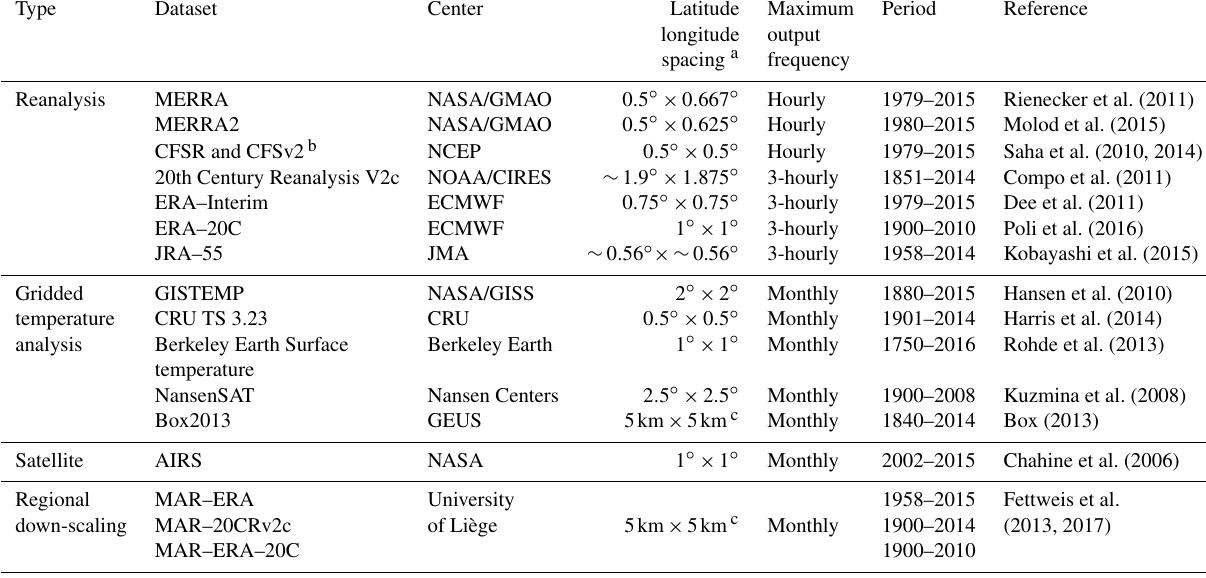
Table 1. Temperature products assessed in this work. Latitude longitude spacing refers to the grids downloaded for this work (not necessarily the native model grid). Maximum output frequency refers to the maximum available – monthly averages are used in the